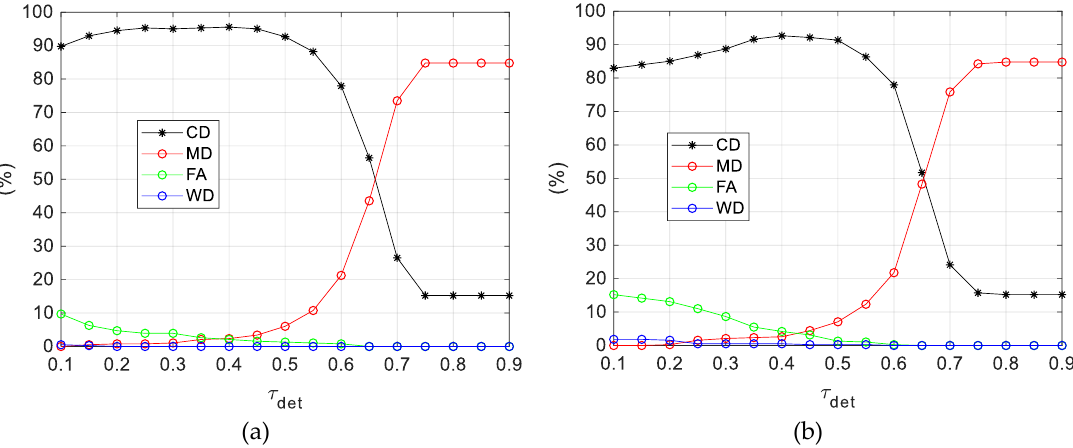
Figure 13. DL-based detector performance as a function of τ det . FT3-A composed of 381 frames. ( a ) Target UAV prediction enabled ( d u = 100 pixels, N w = 7 search windows). ( b ) Target UAV prediction disabled ( d u = d v = 100 pixels, N w = 28 search windows).